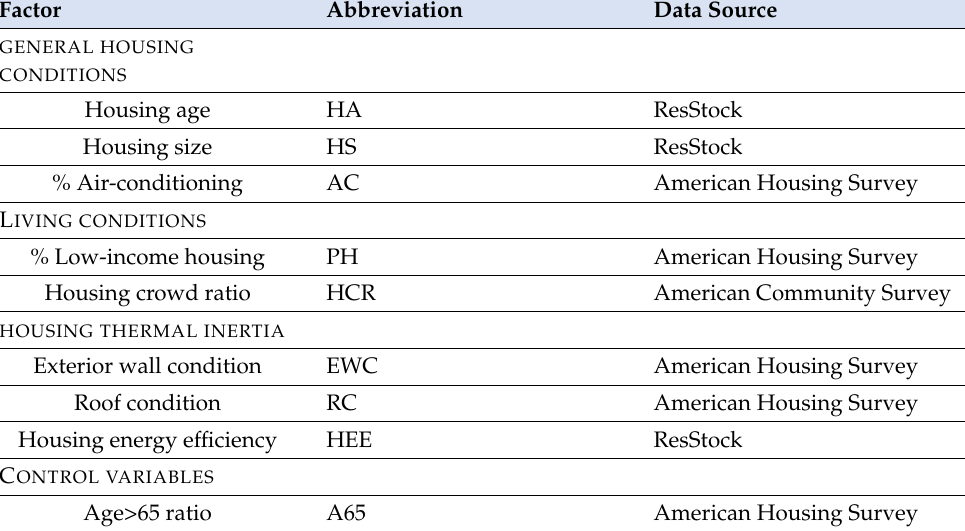
Table 1. Housing characteristic variables.